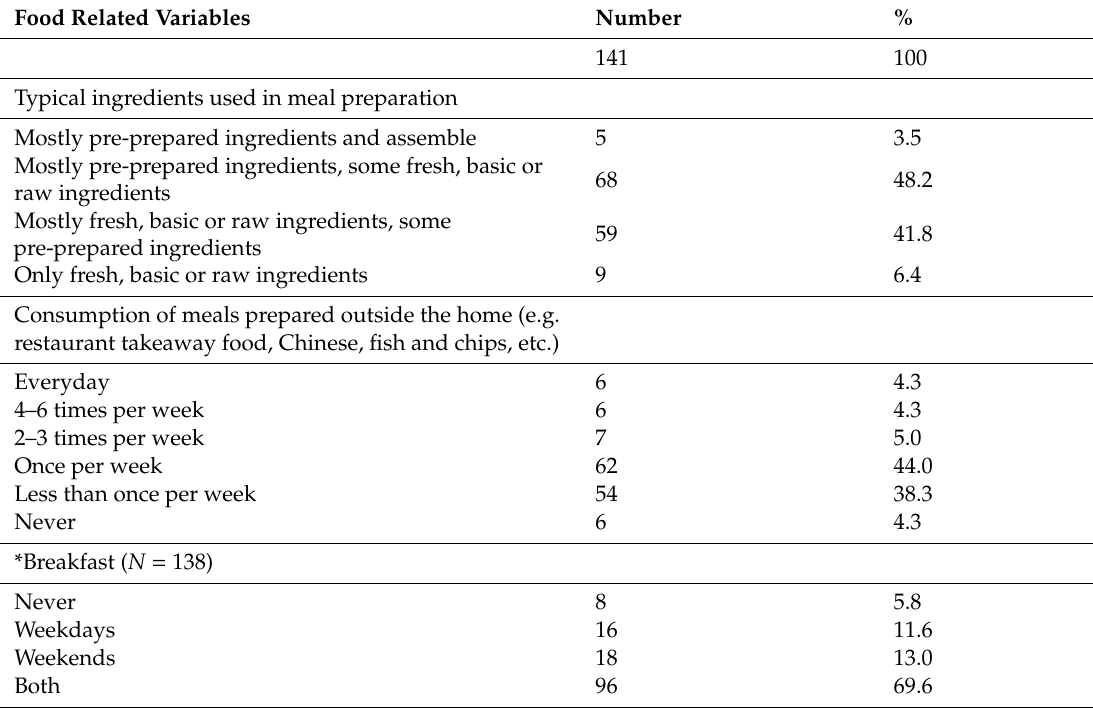
Table 3. Food Related Characteristics of Participants ( N =